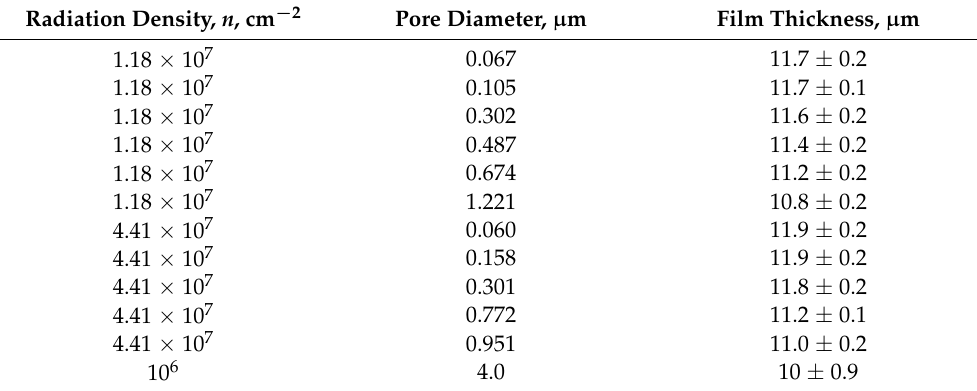
Table 2. Characteristics of TMs used for relative